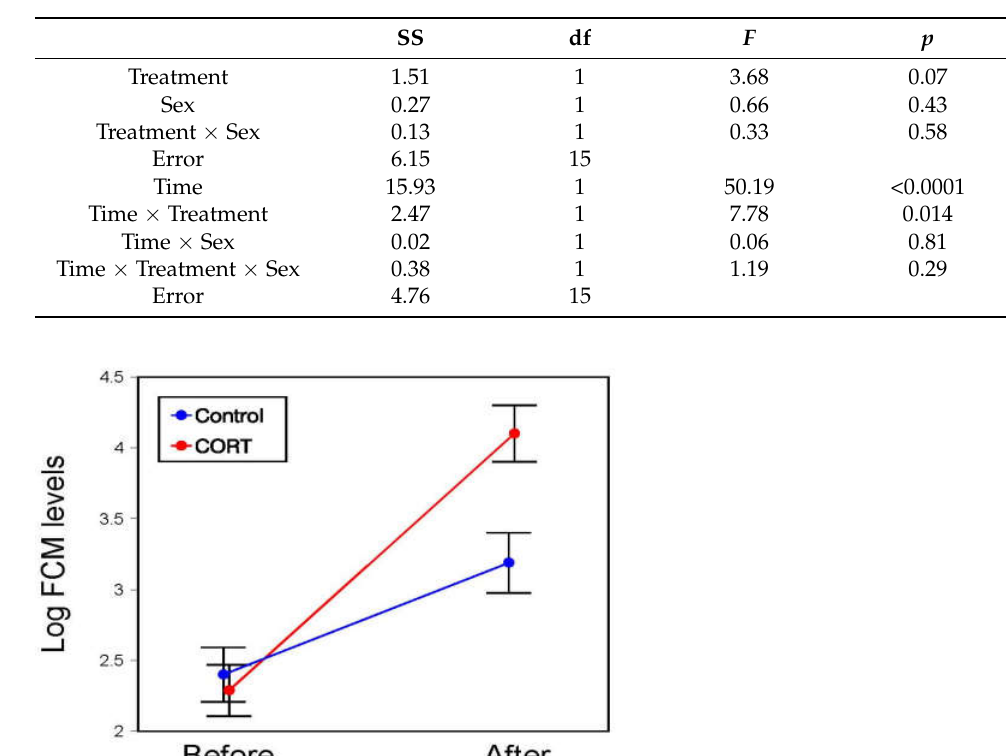
Table 1. Results of a GLM testing the effects of a corticosterone supplementation experiment on the fecal corticosterone metabolites (FCM) levels of the amphisbaenian T. wiegmanni .